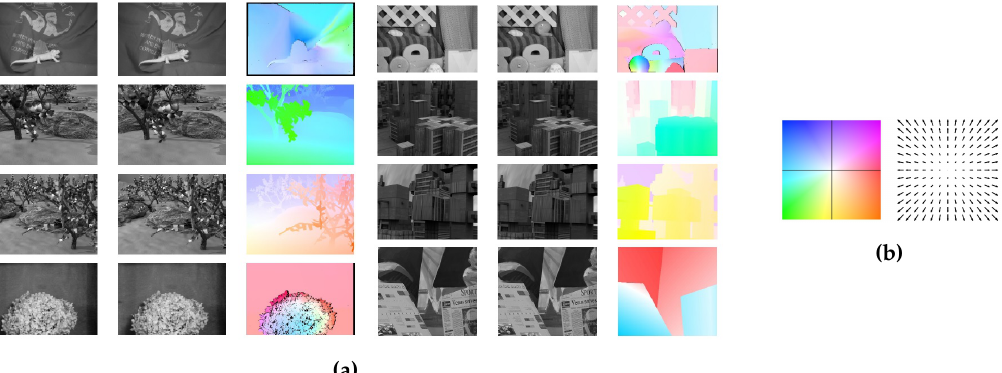
Figure 4. ( a ) The set of input image pairs (gray-valued images), as well as the ground truth (colored images) of the optical flow used for assessing the performance of the eight dense descriptors for optical flow estimation; ( b ) code for the visualization of the flow fields.